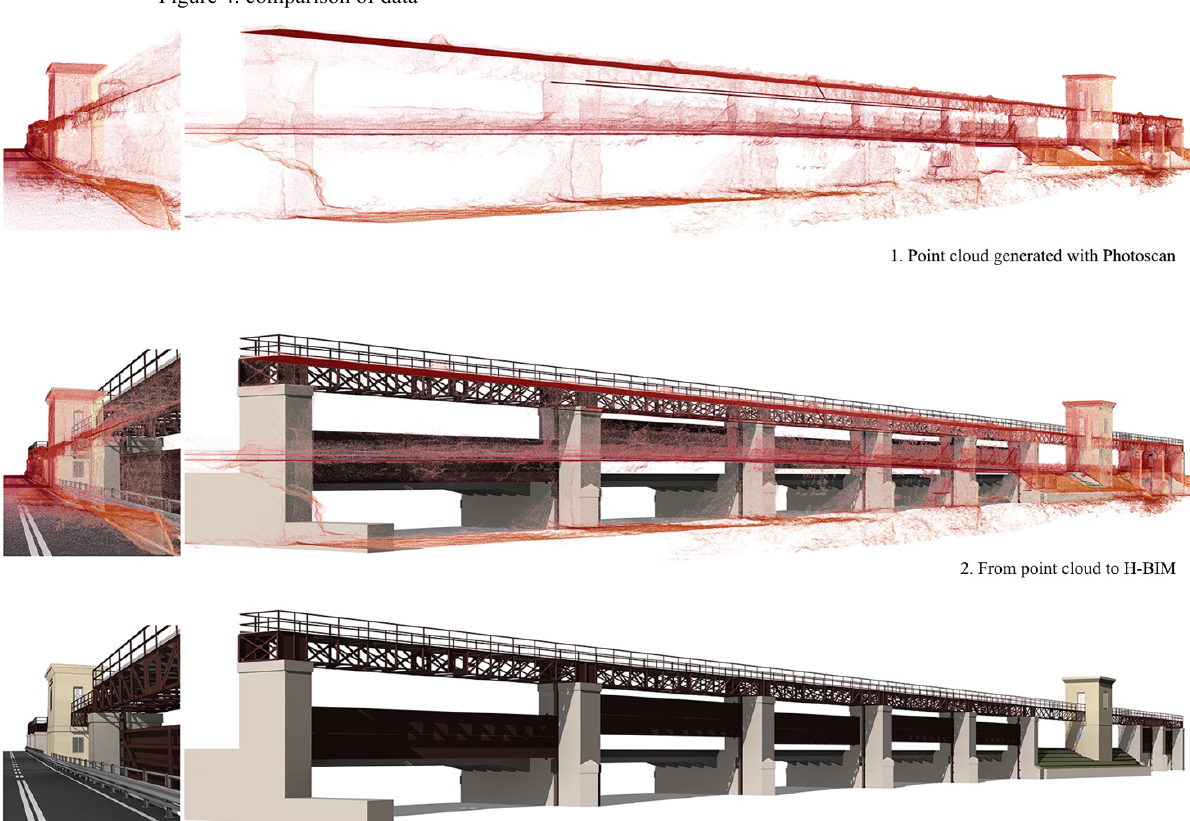
Figure 5. H-BIM process: from point cloud to